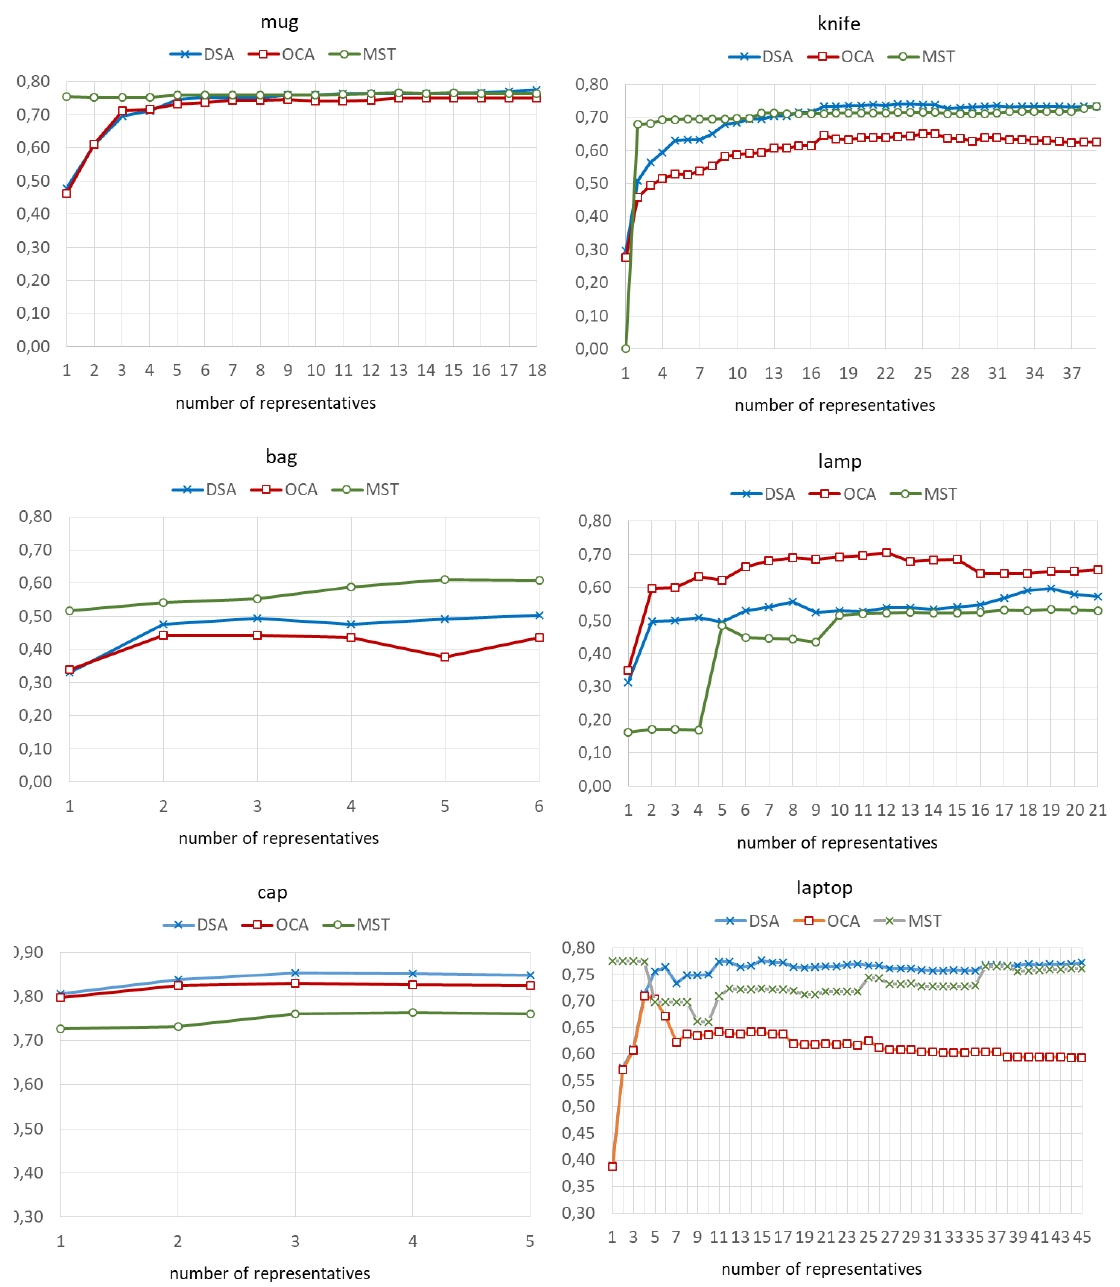
Figure 6. Component association accuracy depending on the number of representatives and the applied method measured by